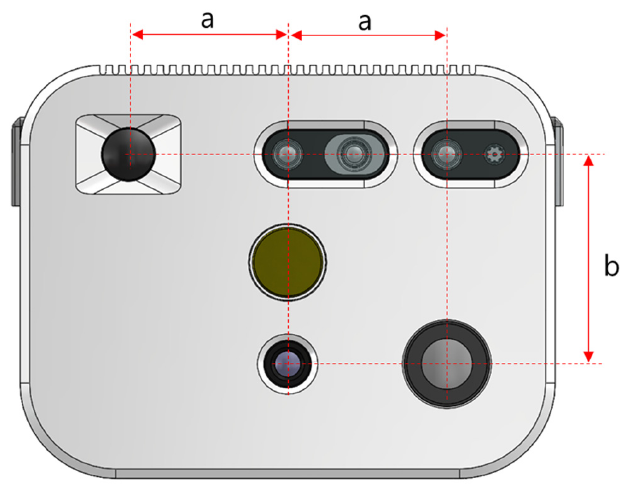
Figure 3. Arrangement of sensors. (a) Horizontal distance and (b) vertical distance. Table 1. Field of view for multi-modal sensors.